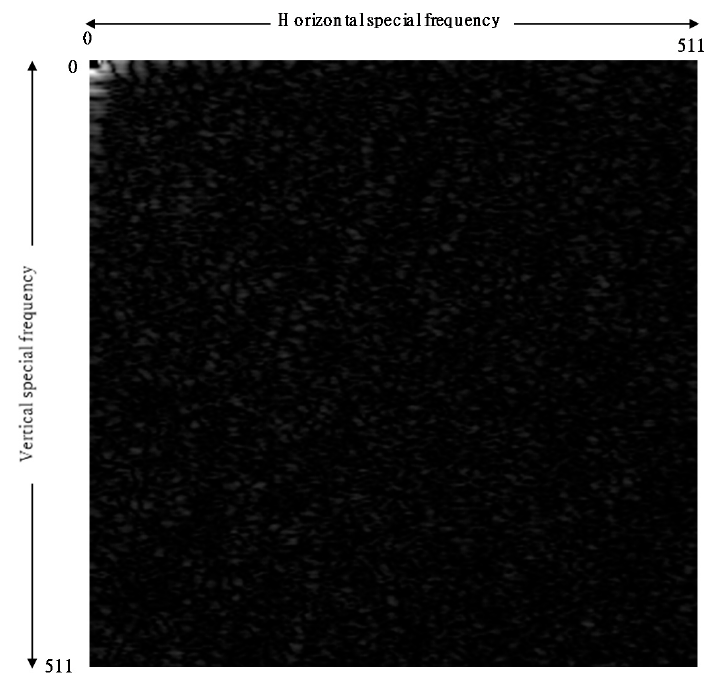
Figure 6. Two-dimensional auto correlation in spatial domain.